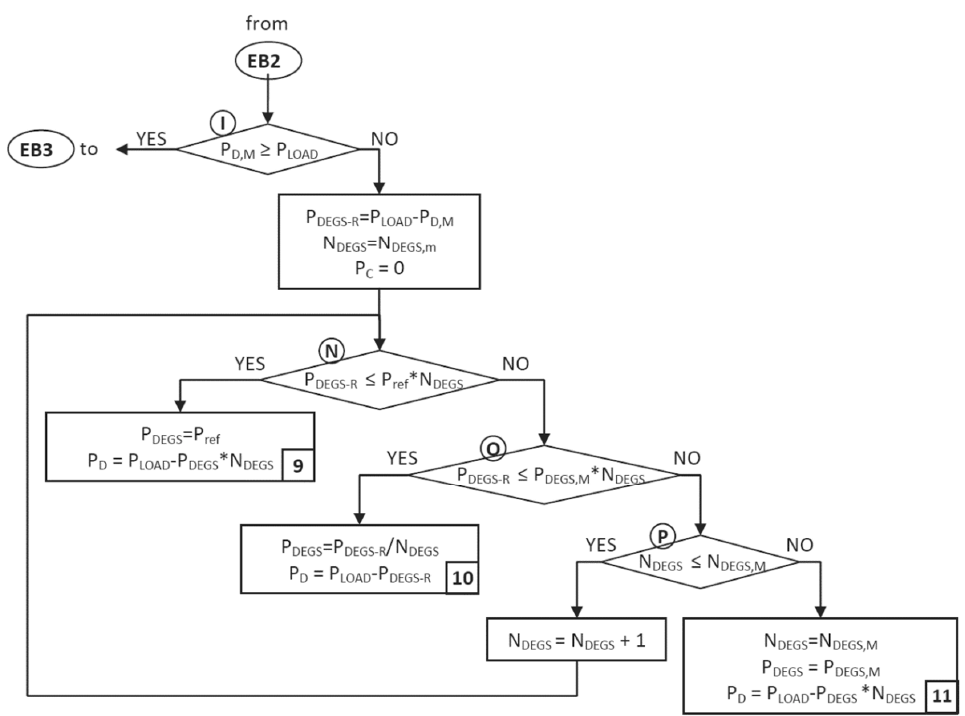
Figure 8. Control logic flow chart—evaluation block EB4.